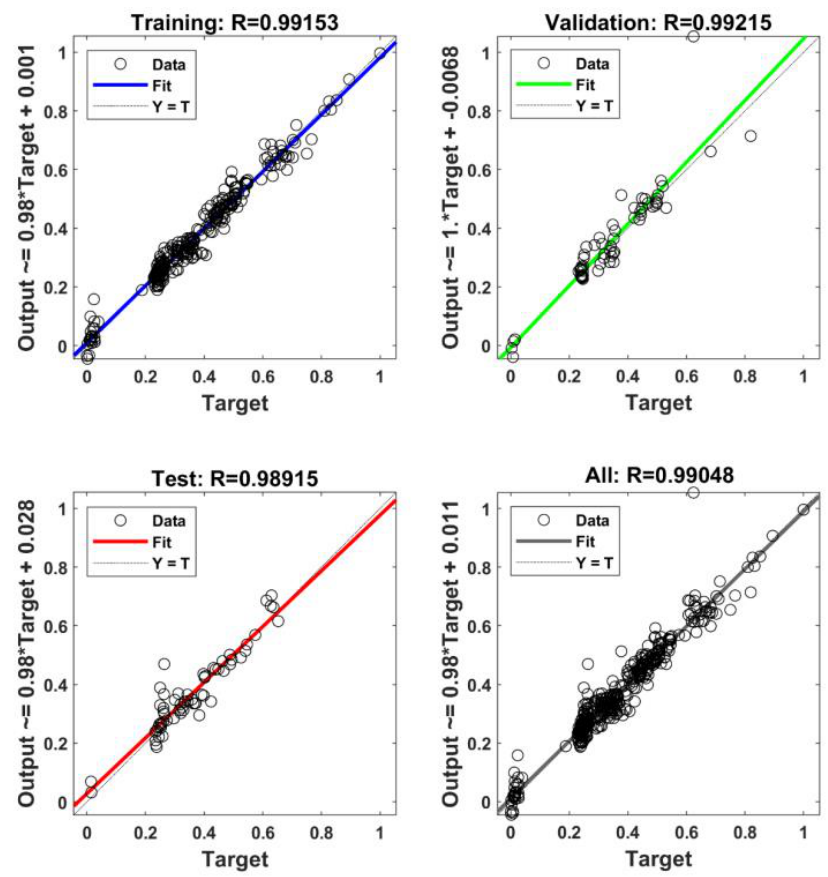
Figure 11. Correlation coefficient curves of the CWQM model.